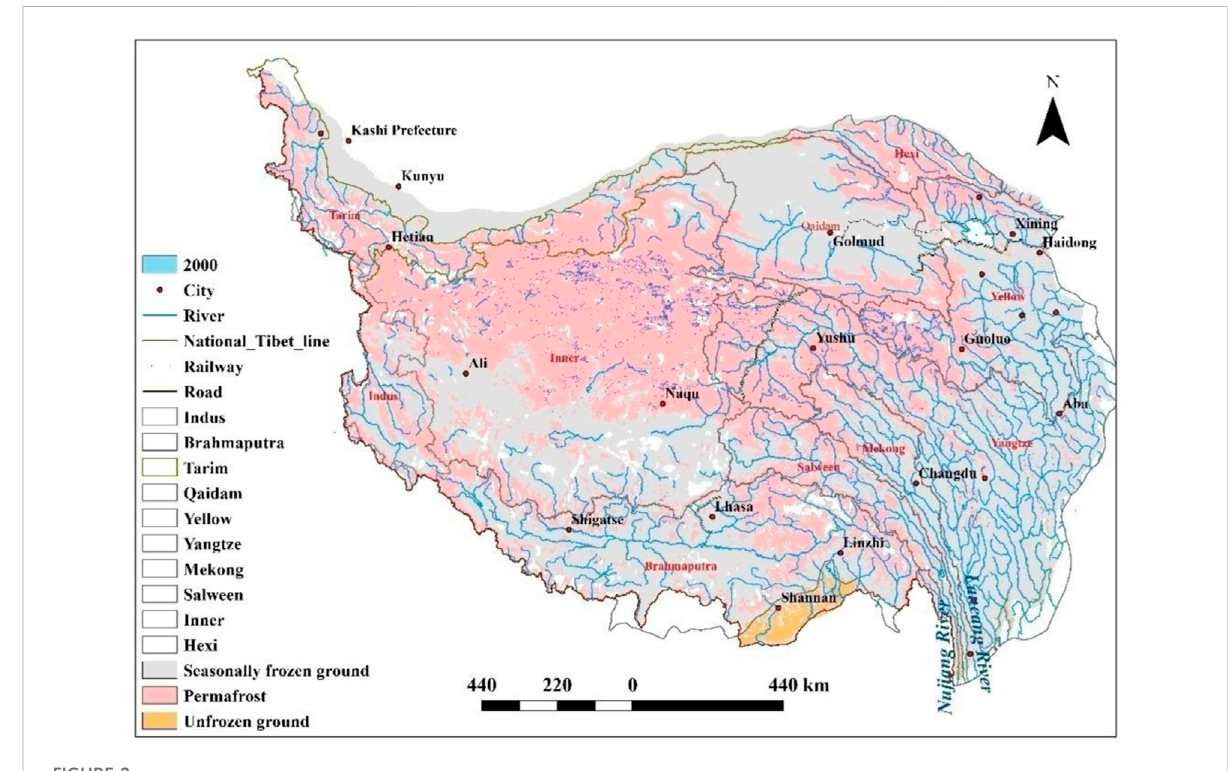
FIGURE 2 Thermokarst lakes in